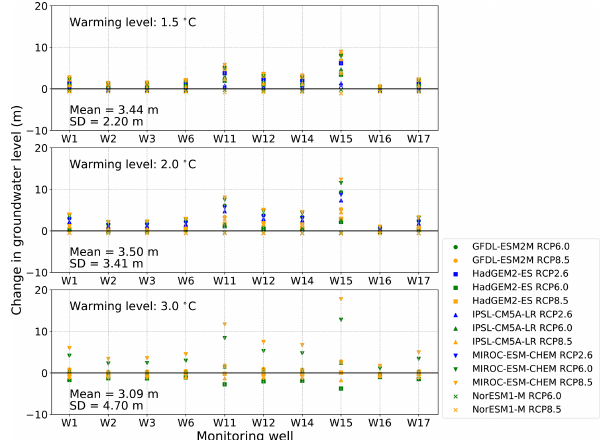
Figure 6. Changes of simulated groundwater levels in monitoring wells under three warming scenarios compared to the baseline sce- nario. The positions of monitoring wells are shown in Fig.